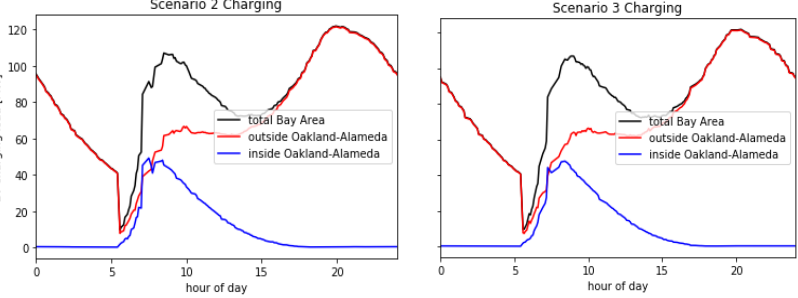
Figure 6. EV charging loads for scenario 2 and scenario 3.